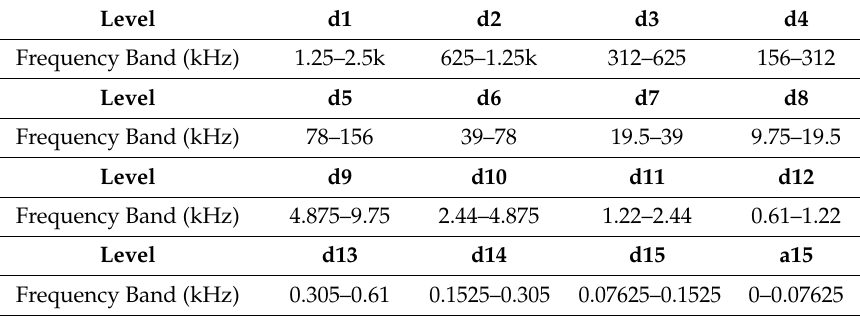
Table 1. Frequency band of each level at 5 MHz sampling